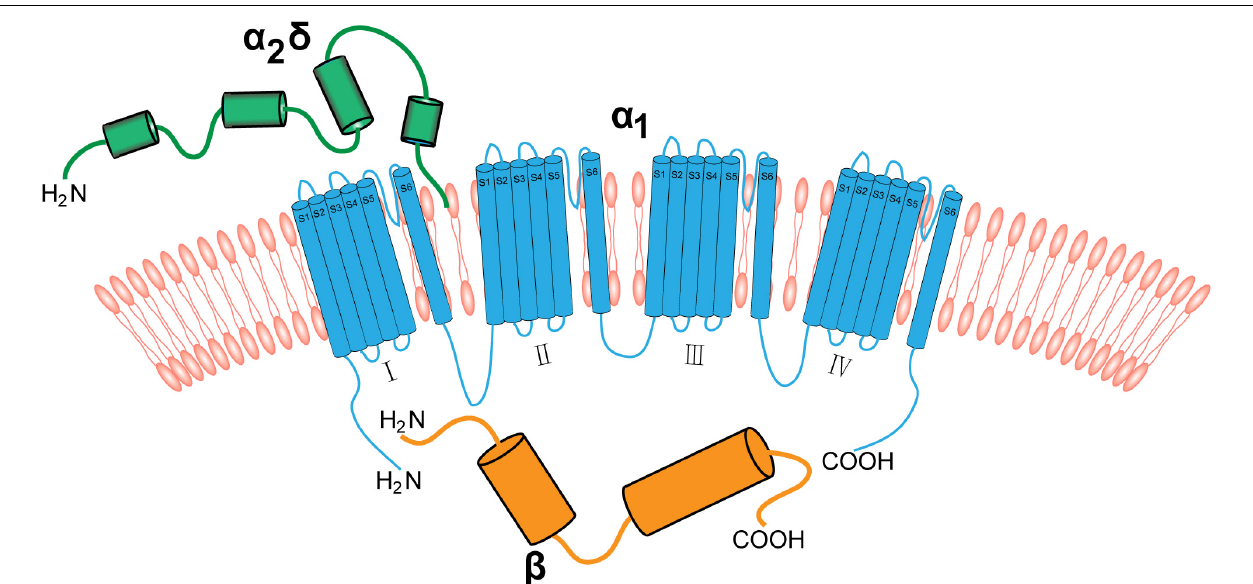
FIGURE 1 | The neuronal voltage-gated calcium channel complex. Voltage-gated calcium channels include the transmembrane pore-forming α 1 subunit (red), extracellular α 2 δ (green), and cytoplasmic β (blue) subunits. The α 1 subunit is a transmembrane protein linking the α 2 δ subunit and β subunit. The α 2 δ subunit is mainly extracellular and binds to the membrane via GPI anchors. The β subunit binds to α 1 subunit via the intracellular I–II